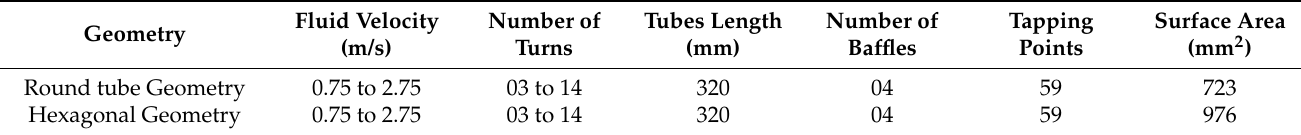
Table 2. Conditions of Round Tubes Heat Exchanger.